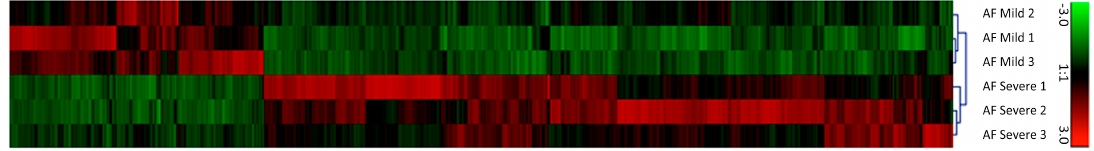
Figure 1. Genesis cluster analysis of native anulus fibrosus (AF) microarray signals from mild and severe degenerated AF.